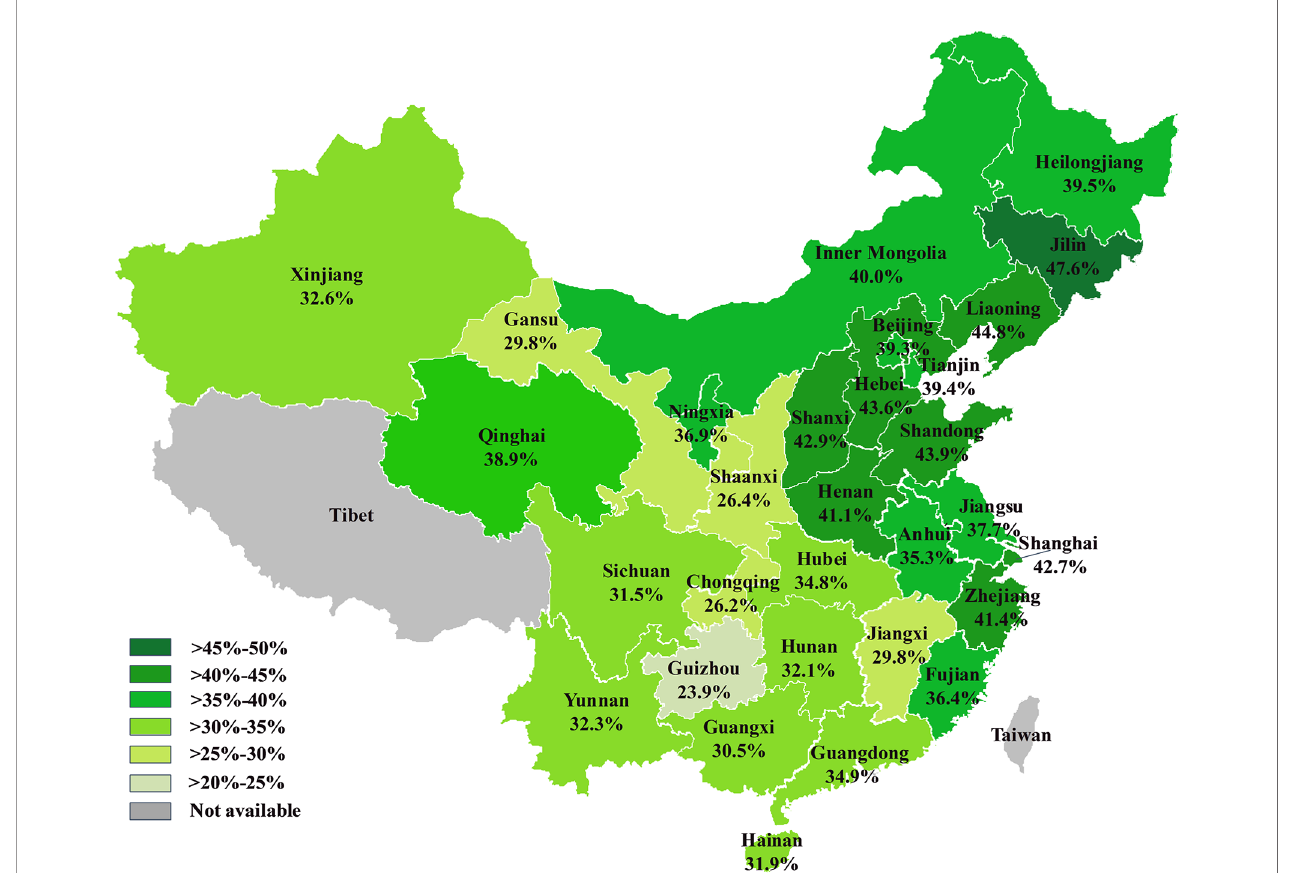
FIGURE 3 | The prevalence of thyroid nodules in 30 provinces and regions of